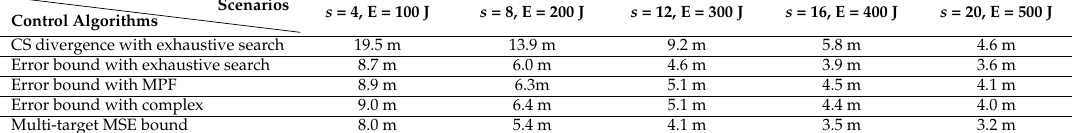
Table 4. 200 MC run averages of final optimal sub-pattern assignment (OSPA) error distance and multi-target MSE bound (Unit: m).